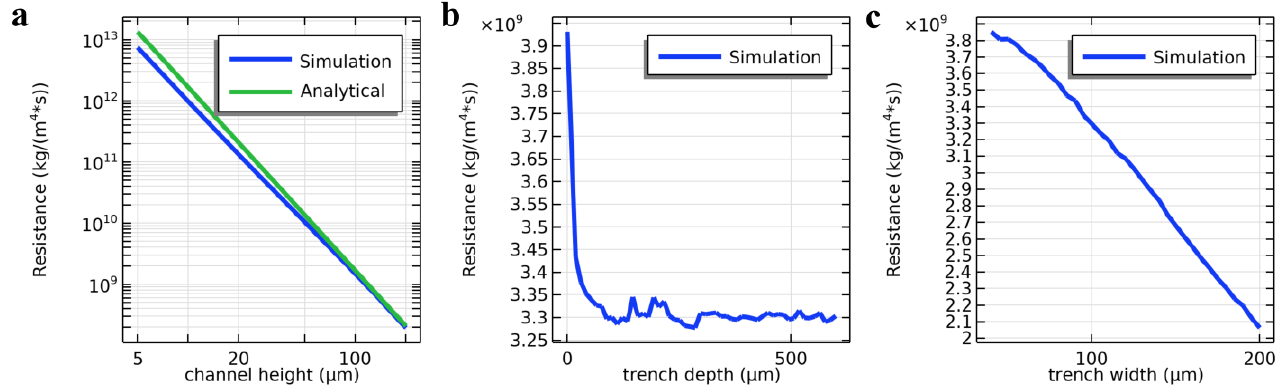
Figure 4. ( a ) Fluidic resistance as a function of the height of the channel above the trenches. ( b ) Fluidic resistance depending on the depth of the trenches; the analytically calculated resistance at zero depth amounts to 3.9 × 10 9 kg m 4 s ⁄ . ( c ) Fluidic resistance for varying width of the trenches. Again, the resistance at zero width amounts to 3.9 × 10 9 kg m 4 s ⁄ .